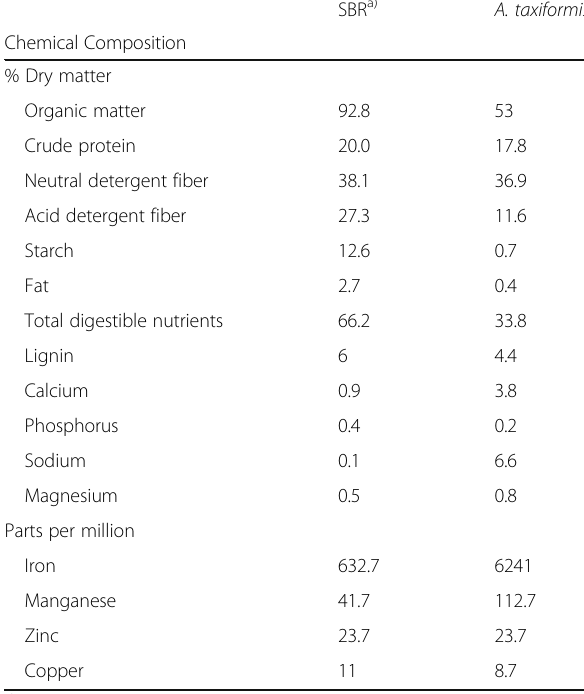
Table 1 Composition of SBR and Asparagopsis taxiformis